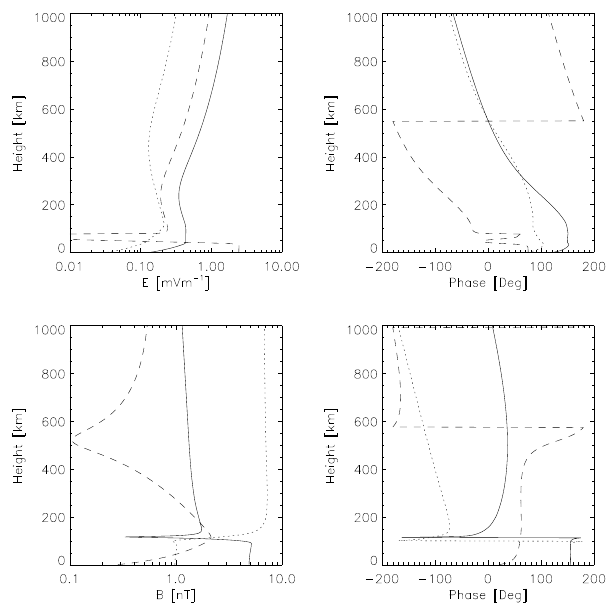
Fig. 1. ULF wave fields at L=1.6 for local midday summer. The solid lines are the X (north-south), the dotted lines are the Y (east- west) and the dashed lines are the Z (vertical) ULF field com- ponents. The values for the ULF wave model were f =50mHz, k x = 3 . 5 × 10 − 6 m − 1 , k y = 7 . 0 × 10 − 7 m − 1 with an incident shear Alfv´en mode at 1000km